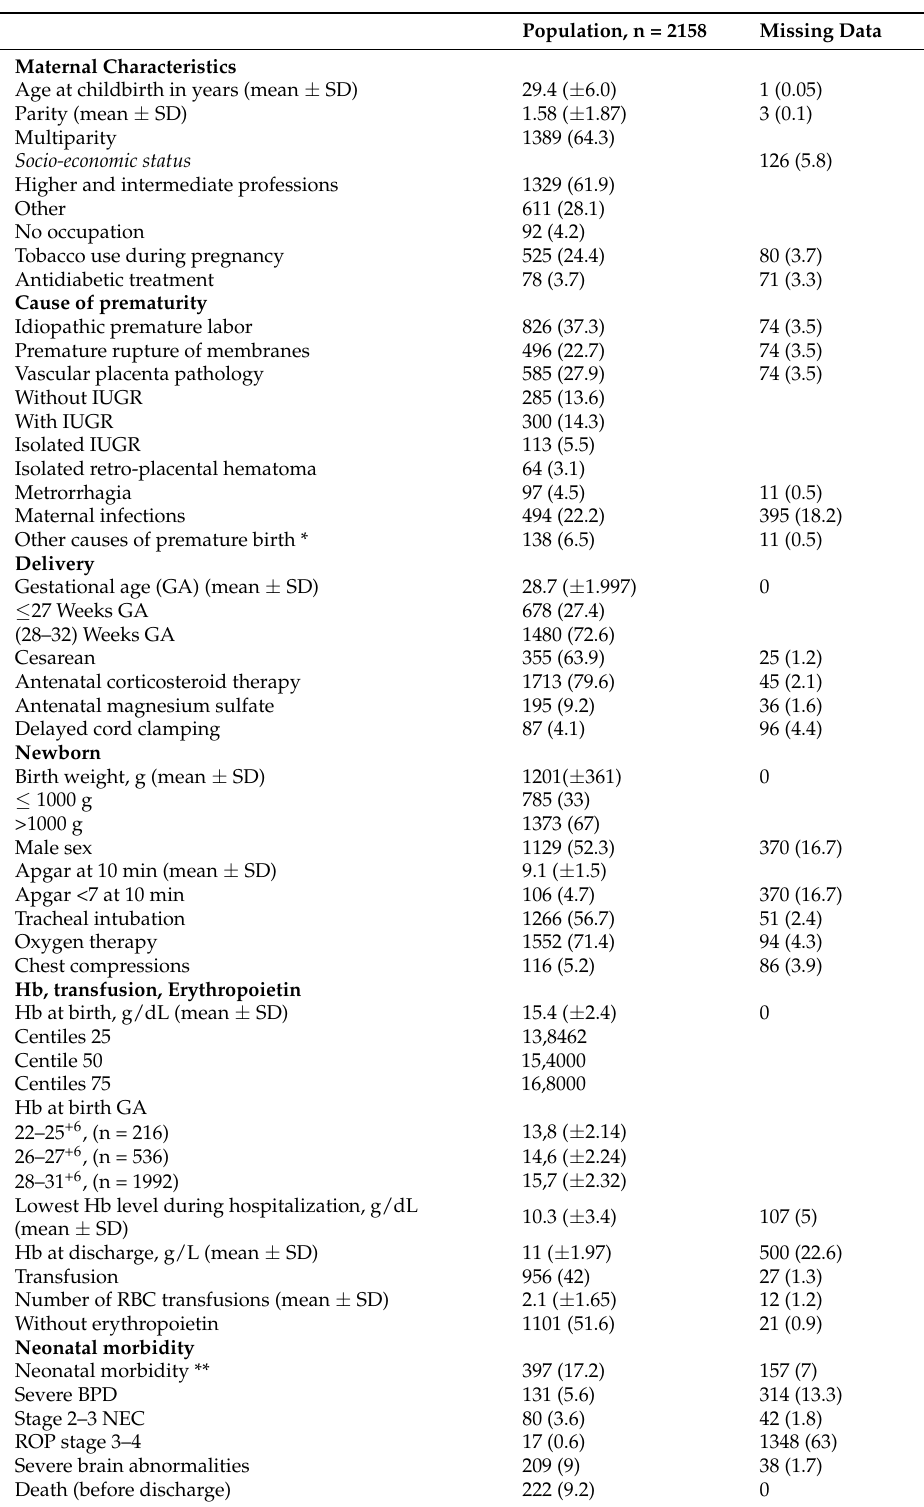
Table 1. Maternal, obstetrical, and neonatal